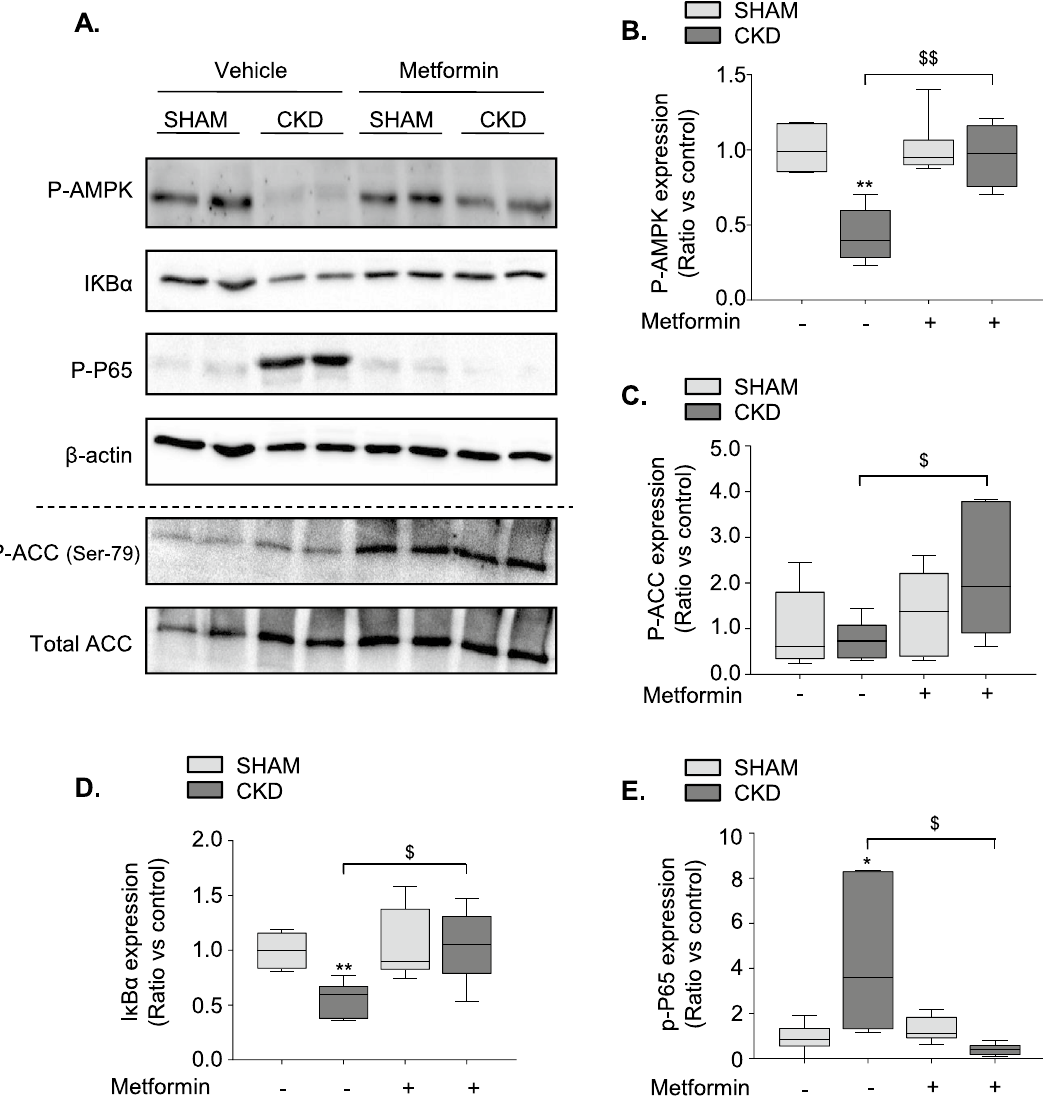
Figure 4. Metformin pre-conditioning enhances adenosine monophosphate-activated protein kinase (AMPK) activation and reduces canonical NFκB activation in CKD mice. ( A ) Representative images of phosho-AMPK, IΚBα, phospho-P65, phospho-ACC (Ser-79) and total-ACC western blots performed on SHAM and CKD mice exposed, or not, to metformin. ( B ) Quantitative data showing higher AMPK phosphorylation in ischemic hemispheres of CKD-metformin than CKD-vehicle treated mice. ( C ) Quantitative data showing higher ACC phosphorylation in ischemic hemispheres of CKD-metformin than CKD-vehicle treated mice. ( D ) Quantitative data showing higher IΚBα expression in ischemic hemispheres of CKD-metformin than CKD-vehicle treated mice. ( E ) Quantitative data showing lower P65 phosphorylation in ischemic hemispheres of CKD-metformin than CKD-vehicle treated mice. Results are expressed as the median, interquartile, and min–max and show data from at least 6 animals per group. Statistical analysis was performed using a non-parametric Mann–Whitney test. *p < 0.05, **p < 0.01, CKD-vehicle vs. SHAM-vehicle mice. $ p < 0.05, $$ p < 0.01, CKD-metformin vs. CKD- vehicle